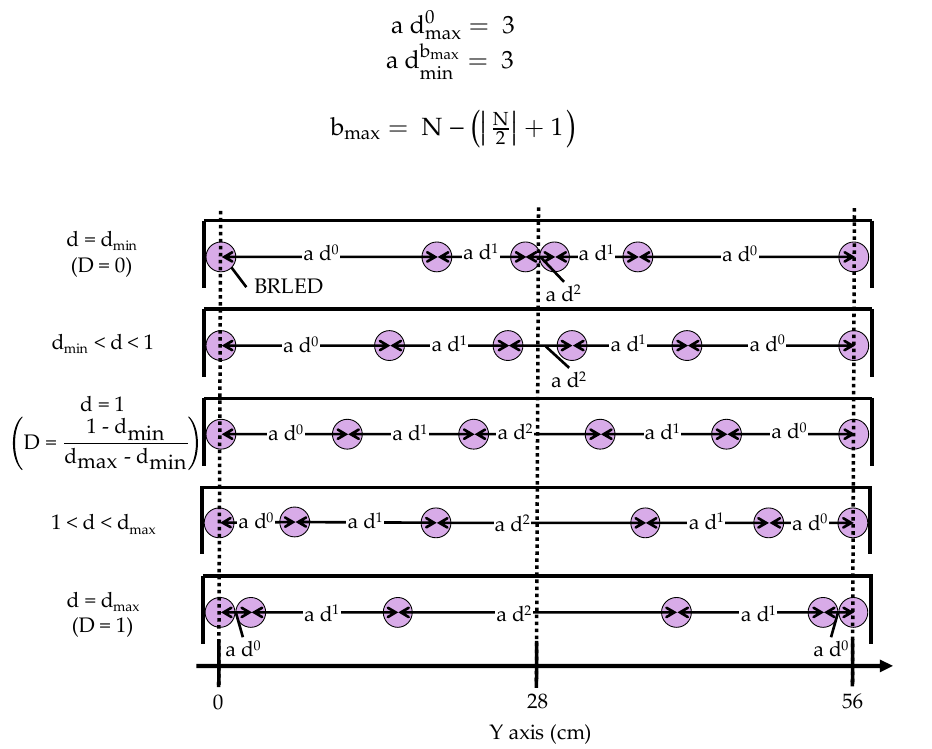
Figure 7. The layouts of 6 BRLED lamps in several d and D conditions, shown in the cross-section view. d is the parameter of the distances of neighboring BRLED lamps, and D is normalized d based on the maximum (d max ) and minimum (d min ) values of d. The values of d min and d max vary with the number of BRLED lamps.